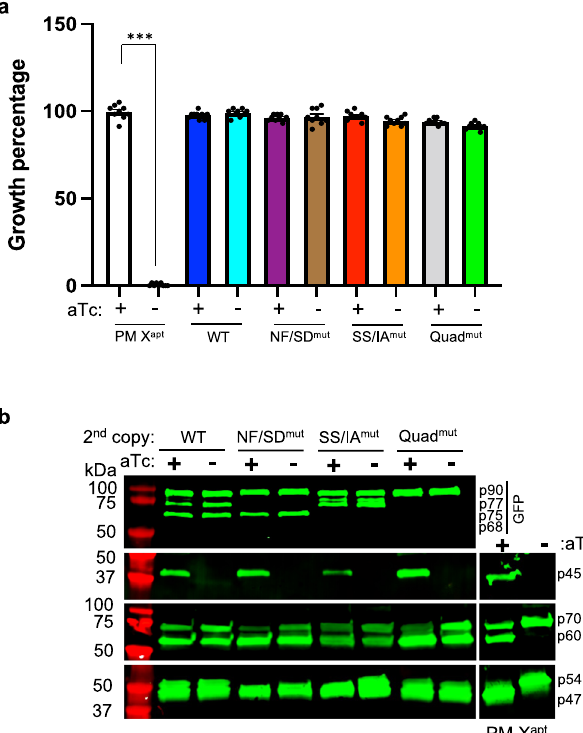
Fig.2|AutocatalyticprocessingofPMXisnotrequiredforparasitereplication and substrate cleavage. a The parental PM X apt parasites or PM X apt parasites expressing the indicated PM X as a second copywere grown either inthe presence or absence of aTc for 96h. The starting parasitemia was 1% across different sam- ples. Shown are the fi nal parasitemia percentages after 2 erythrocytic cycles, nor- malizedtothatofthePMX apt parasitesgrowninthepresenceofaTcfor96h.Mean values from three independent experiments are shown and error bars represent standard deviations. Data were analyzed statistically by two-tailed Student ’ s t test. *** p =0.00002. b The parasite lines from a were MACS synchronized for 3h and were grown for the next 45h either in the presence or absence of aTc. Parasites were then harvested and whole cell lysates were prepared. Western blots were performed to detect the expression of the second copy PM X-GFP (top panel), endogenous PM X-FLAG (second panel), AMA1 (third panel) and SUB1 (bottom panel). On the right is the PM X apt line without second-copy PM X expression. The antibodies used and the speci fi c molecular weights of the different processed forms of proteins are indicated. This experiment was repeated two times and shown is a representative blot. Source data are provided as a Source Data fi